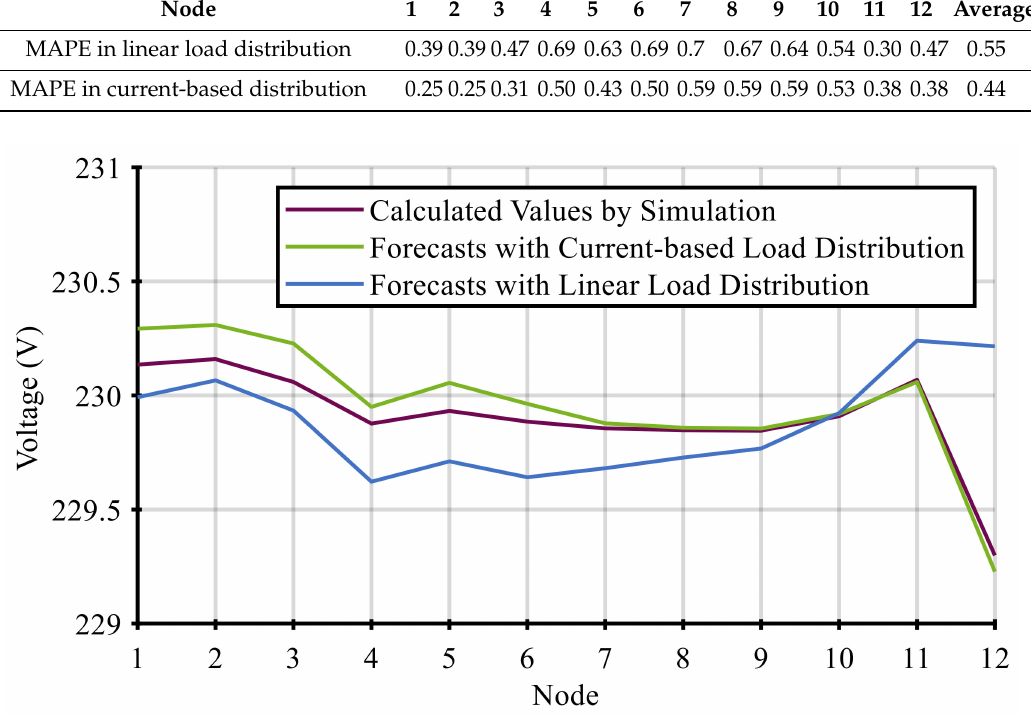
Figure 8. Improvement of the forecasts by using the current-based load distribution (one time step).